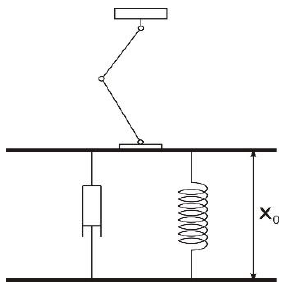
Figure 5. Interaction between the robot and ground surface.